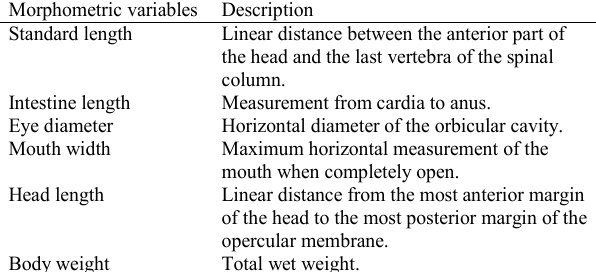
Table 2. Morphometric variables measured in Iheringichthys labrosus